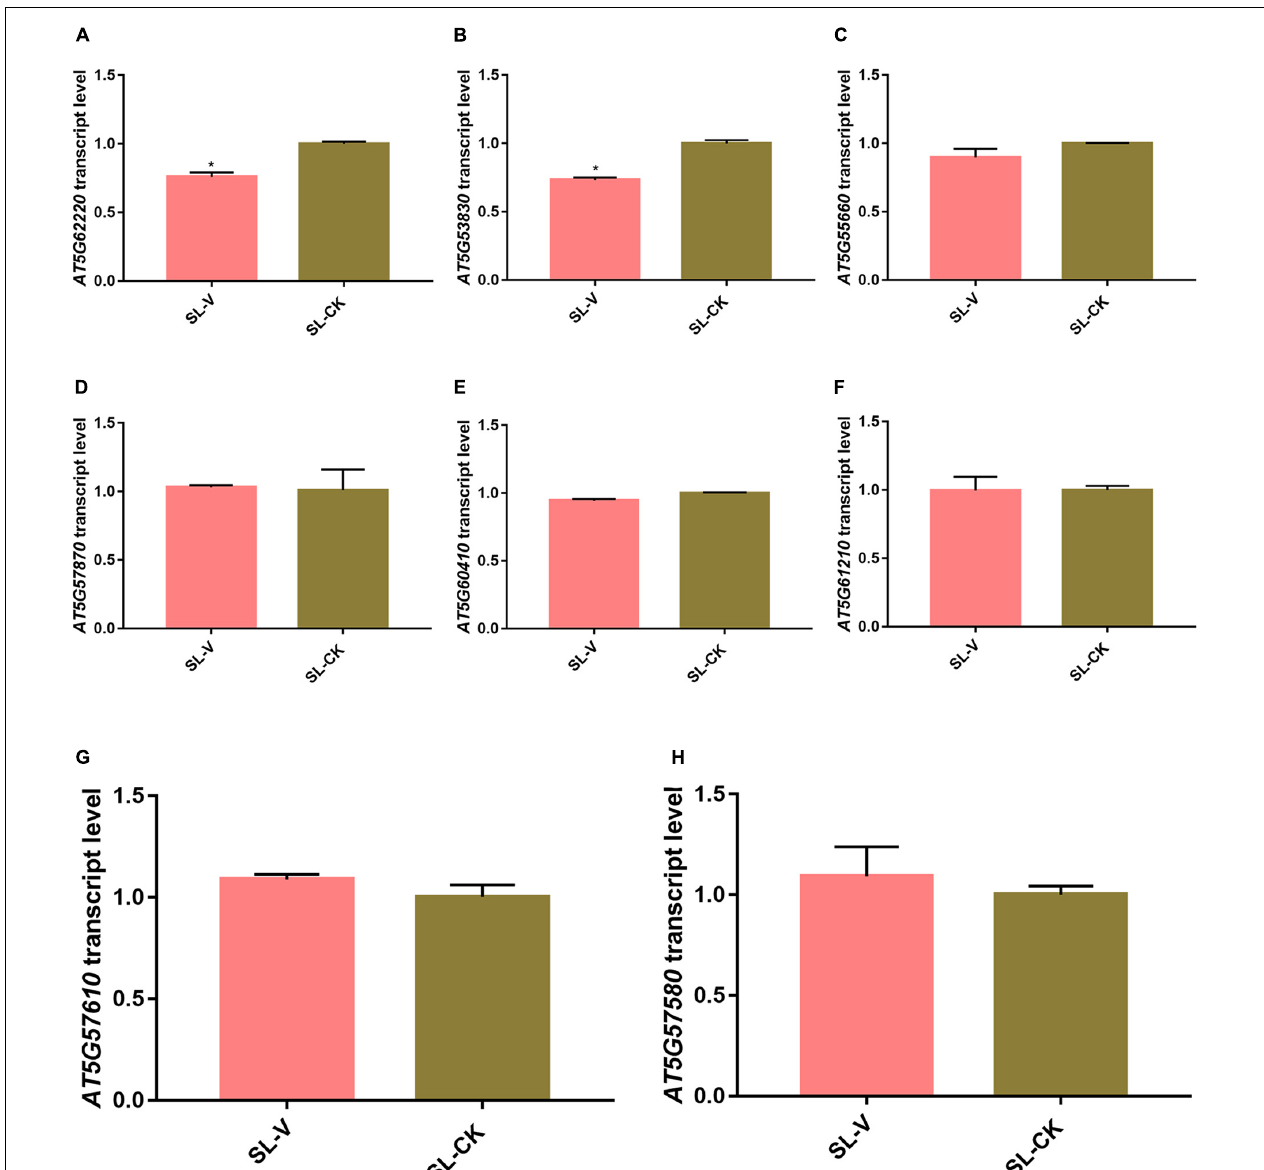
FIGURE 9 | Quantitative real-time PCR (RT-qPCR) analysis of mRNA abundance of significantly changed phosphoprotein genes. (A–H) mRNA abundance of AT5G62220 (A) , AT5G53830 (B) , AT5G55660 (C) , AT5G57870 (D) , AT5G60410 (E) , AT5G61210 (F) , AT5G57610 (G) , and AT5G57580 (H) in systemic leaves of Psm ES4326- and Mock- locally inoculated plants. Expression was normalized relative to ACTIN8. Data are presented as mean ± SE ( n = 3). *Represent p < 0.05 ( t -test).